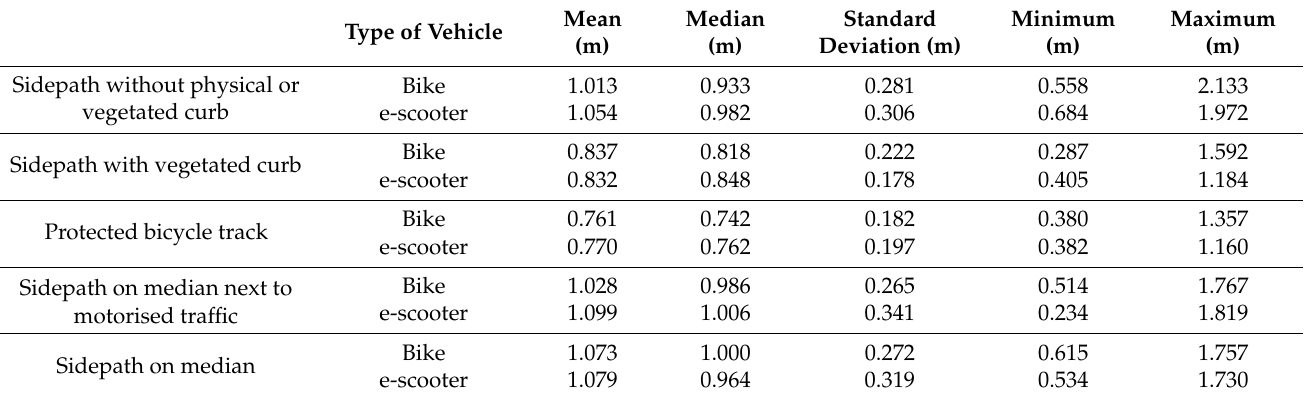
Table 3. Statistical summary of clearance distance during meeting